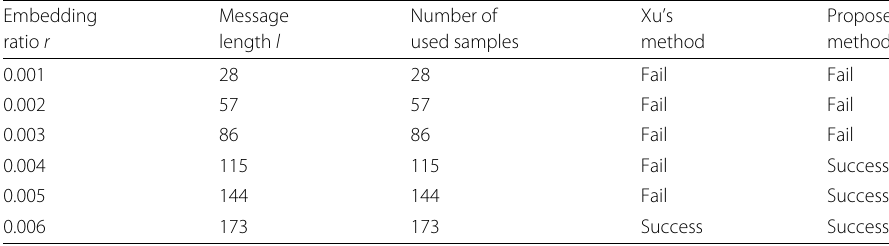
Table 5 Experimental results in the cases of small embedding ratios Embedding Message Number of Xu’s Proposed ratio r length l used samples method